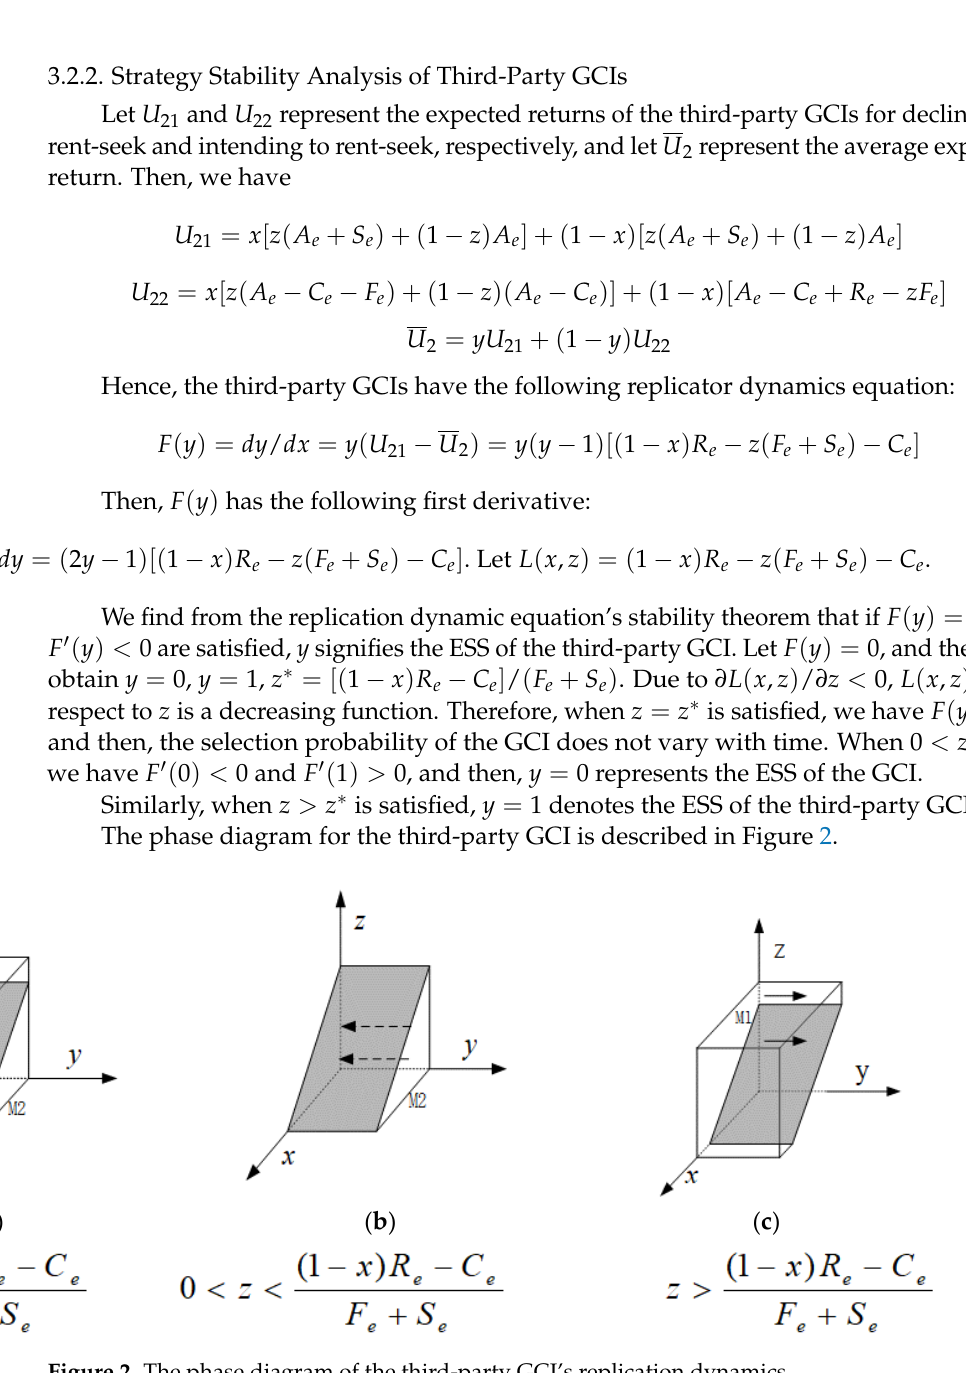
Figure 2. The phase diagram of the third- party GCI’s replication dynamics .